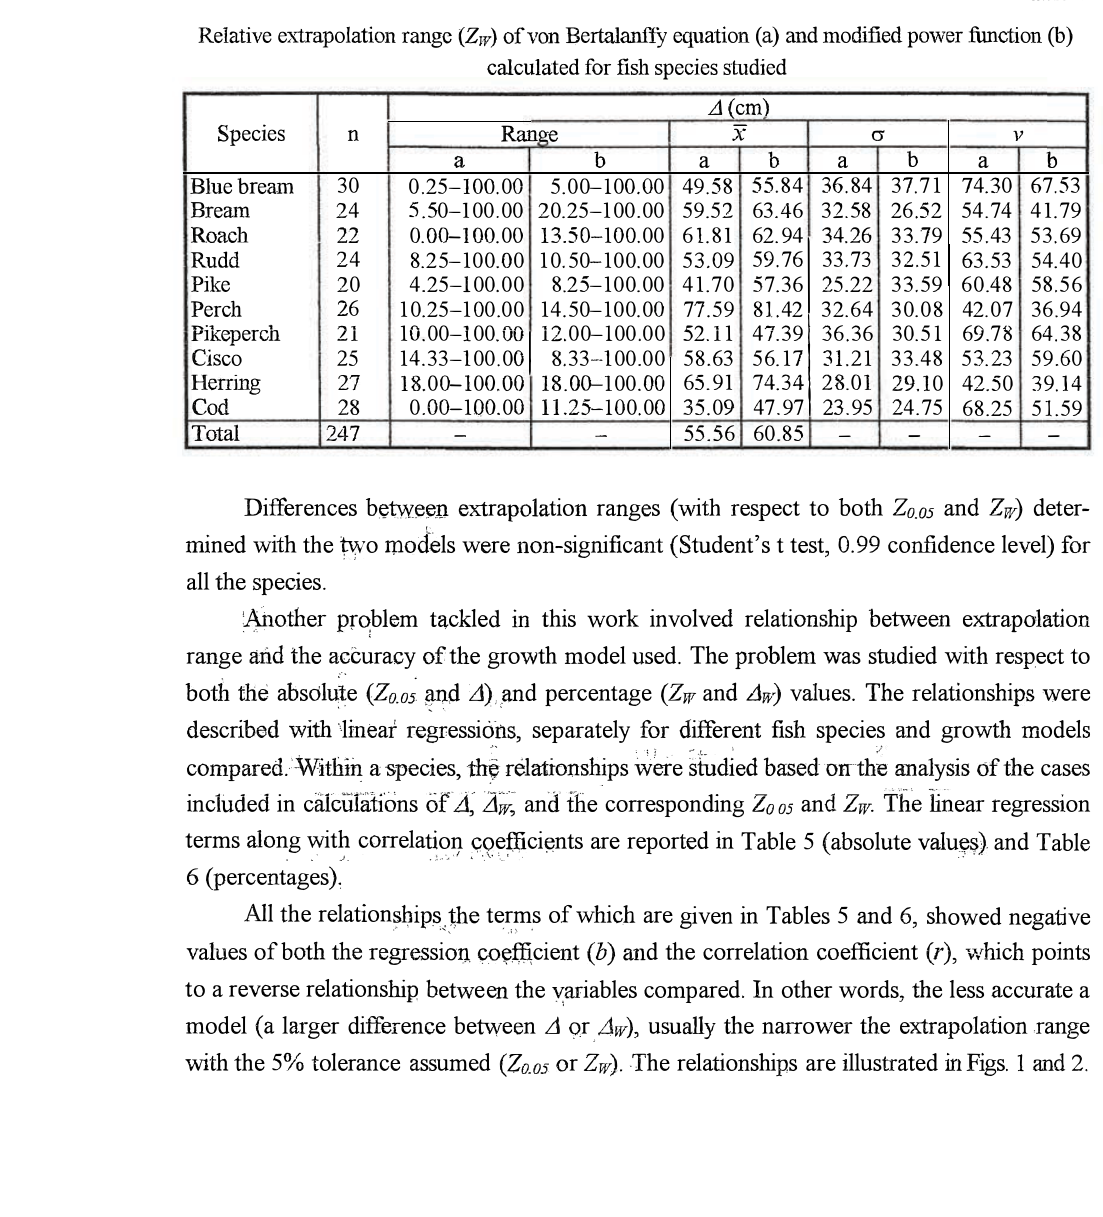
(Zw) ofvon ]3ertalanffy equation (a) and modified power function (b) calculated for fish species